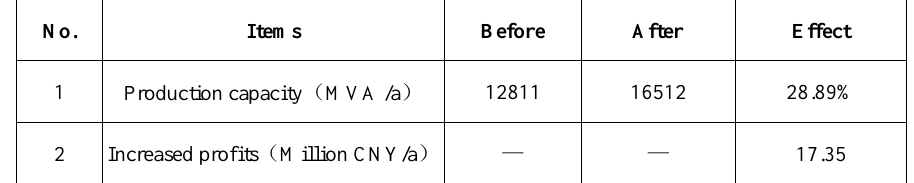
Table 5. Evaluation of improvement